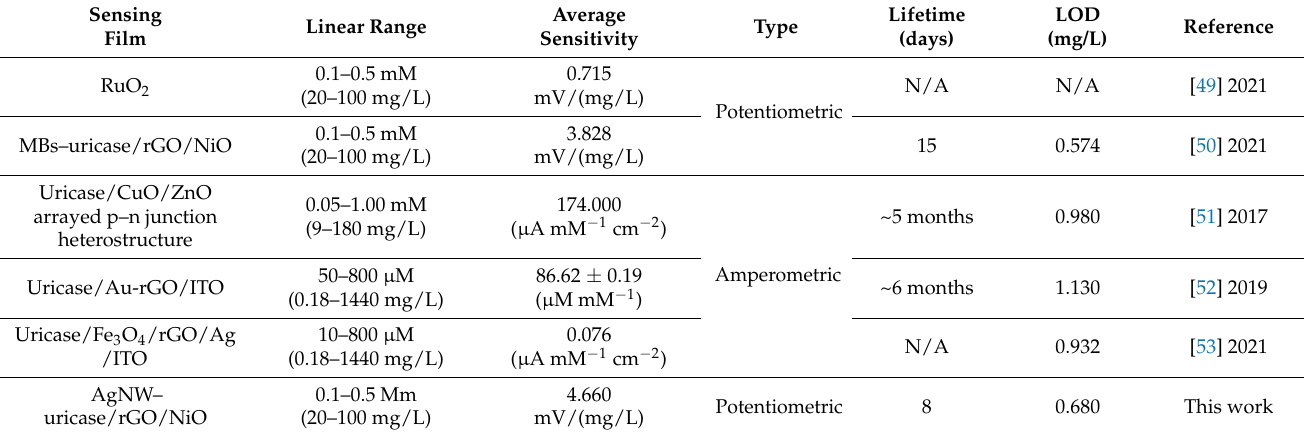
Table 5. Comparisons of the characteristics for the different sensing